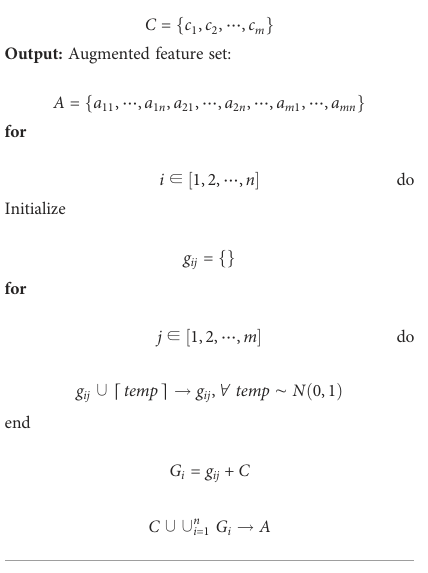
Algorithm 1: Algorithm 1: Data Augmentation Method 1 Input: Cluster feature set: